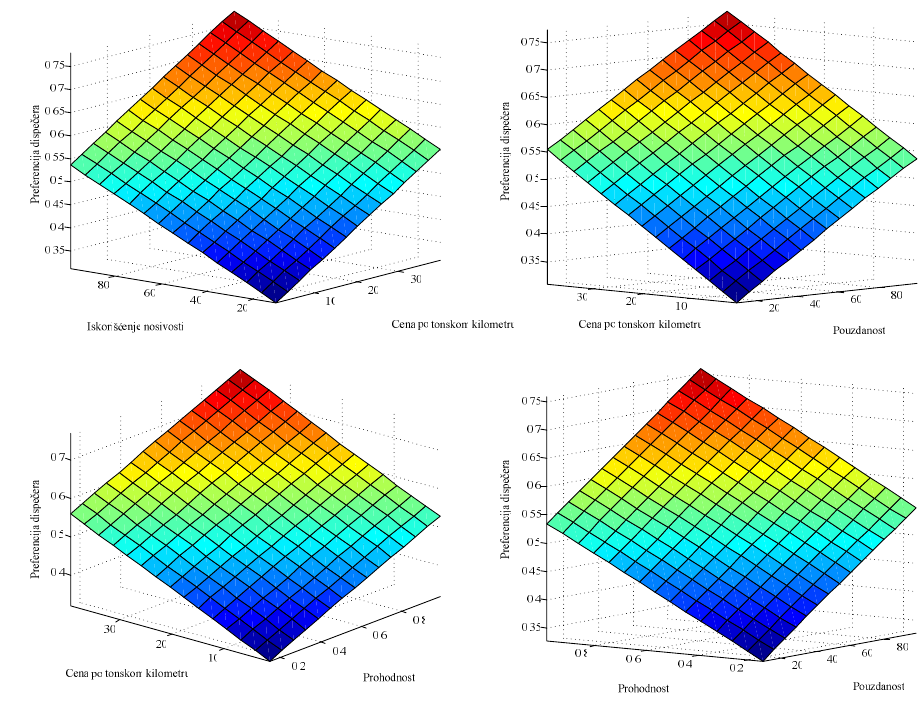
se ponovo predstavlja mreži zbog daljeg podešavanja težina. Neuronska mreža je obu č ena ako može uspešno da rešava zadatke za koje je obu- č avana. Nakon obu č avanja ona može da generalizuje nove ulazne po- datke za koje nije obu č avana. Obu č avanjem neuronske mreže dobijene su vrednosti preferencije dispe č era koje odgovaraju preferenciji dispe č era u praksi. Greška koja se javlja na izlazu iz neuronske mreže je zanemariva, pošto iznosi 0,0003, što je približno jednako nuli. Iz grafi č kog prikaza skupa mogu ć ih rešenja opisanog ANFIS modela (slika 11) vidi se da sistem poseduje dovoljnu osetljivost, potrebnu kontinuiranost i postepenost izlaza.